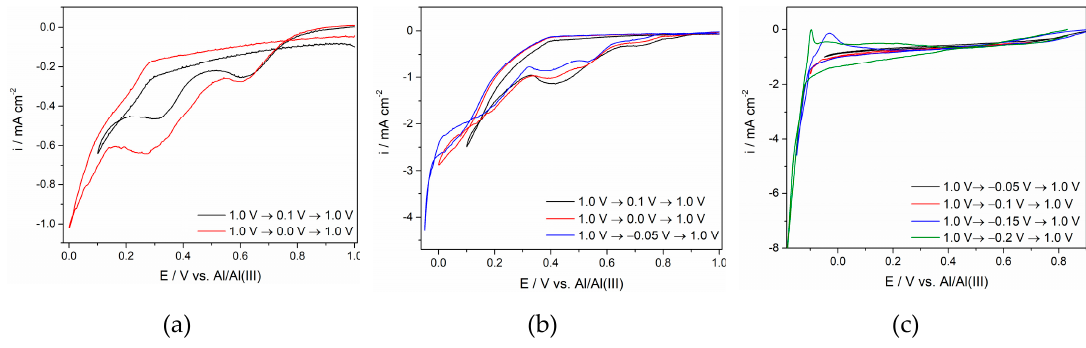
Figure 5. Voltammograms of the glassy carbon (GC) working electrode in the equimolar AlCl 3 -NaCl melt containing anodically dissolved Ti, obtained at different cathodic potential limits and at T = 200 °C with different sweep rates: ( a ) ν = 5 mV·s − 1 ; ( b ) ν = 20 mV·s − 1 ; ( c ) ν = 5 mV·s − 1 .